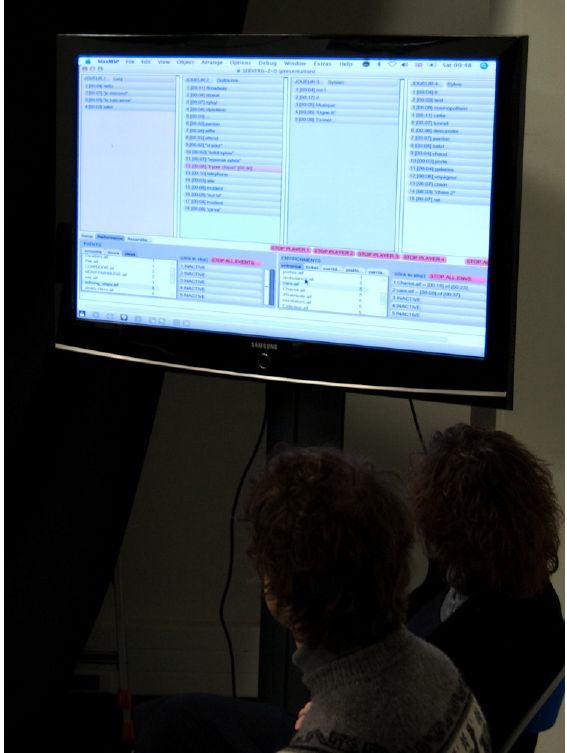
6 | Fig. 6. Server patch in improvisation in